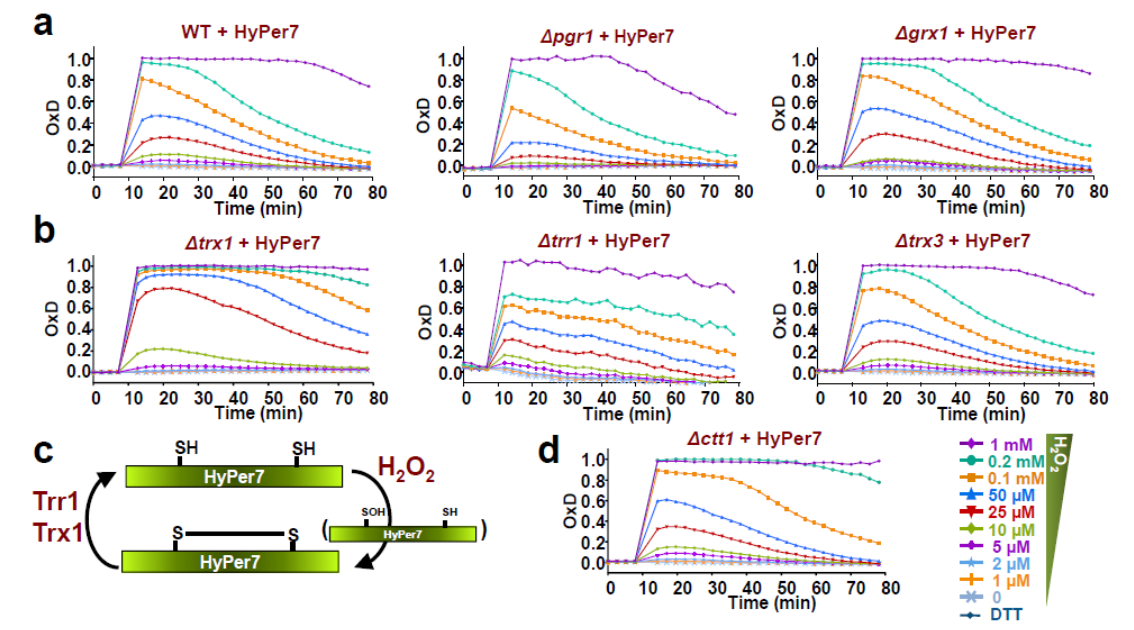
Figure 2. HyPer7 is recycled by the thioredoxin system. ( a,b ) Strains HM123 (WT), AD88 ( ∆ pgr1 ), SG154. ( ∆ trx1 ), SB469 ( ∆ grx1 ), SG152 ( ∆ trr1 ), and MC184 ( ∆ trx3 ), transformed with plasmid p728 expressing cytosolic HyPer7, were treated or not with H 2 O 2 and oxidation of the reporter was estimated as described in Figure 1. ( c ) Scheme depicting the role of the thioredoxin system as the electron donor in HyPer7 recycling. ( d ) Strain EP160 ( ∆ ctt1 ) transformed with plasmid p728 expressing cytosolic HyPer7 was treated or not with H 2 O 2 , and oxidation of the reporter was estimated as described in Figure 1. For each strain, average data from three biological replicates are shown, with error bars (S.D.) displayed in Figure S2.